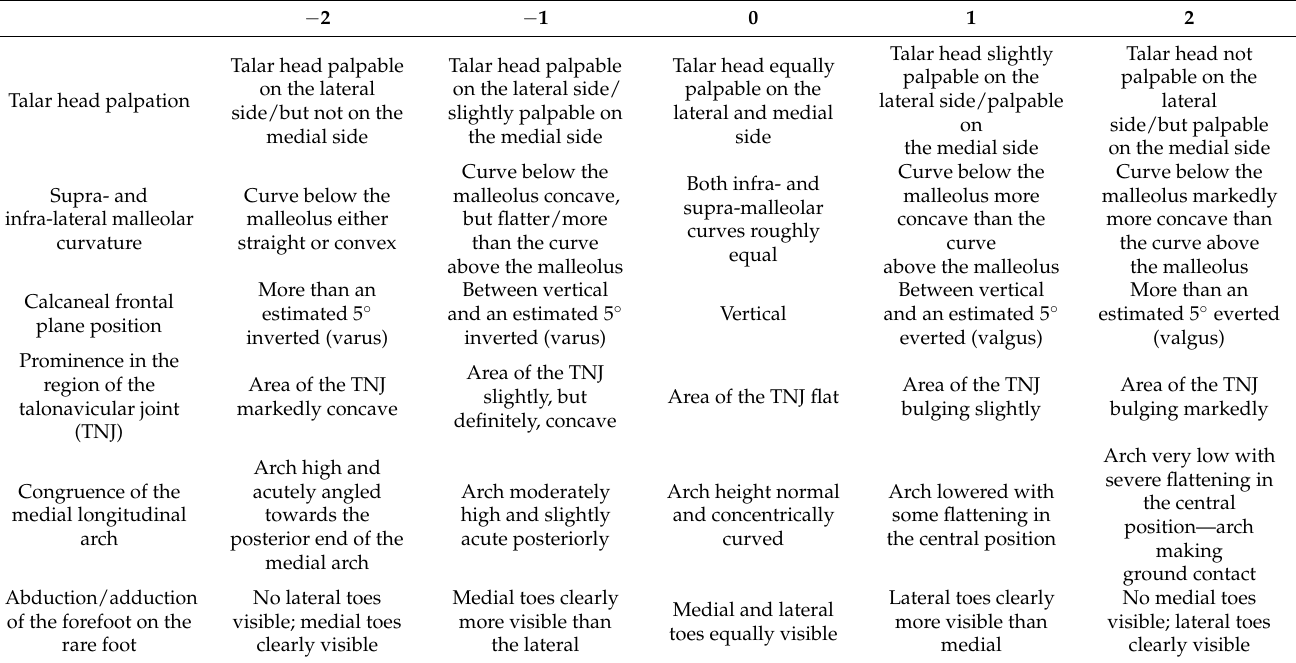
Table 1. Foot Posture Index scoring.